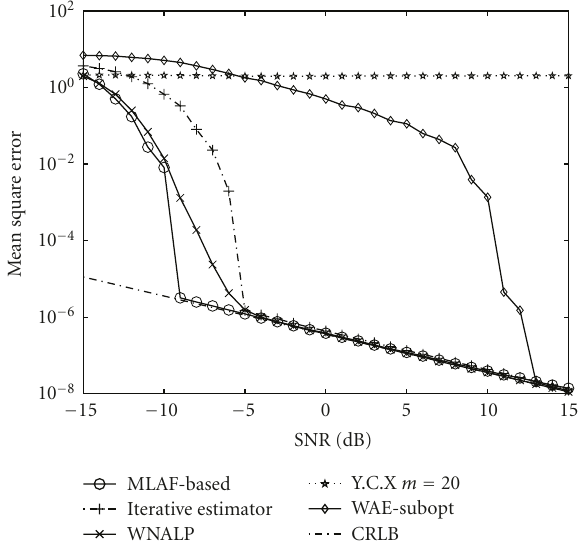
Figure 6: Comparison with periodogram based estimators. Signal frequency randomly distributes between [0,0 . 5 π ]. N = 80. For the MLAF-based estimator, q = 4 and τ =